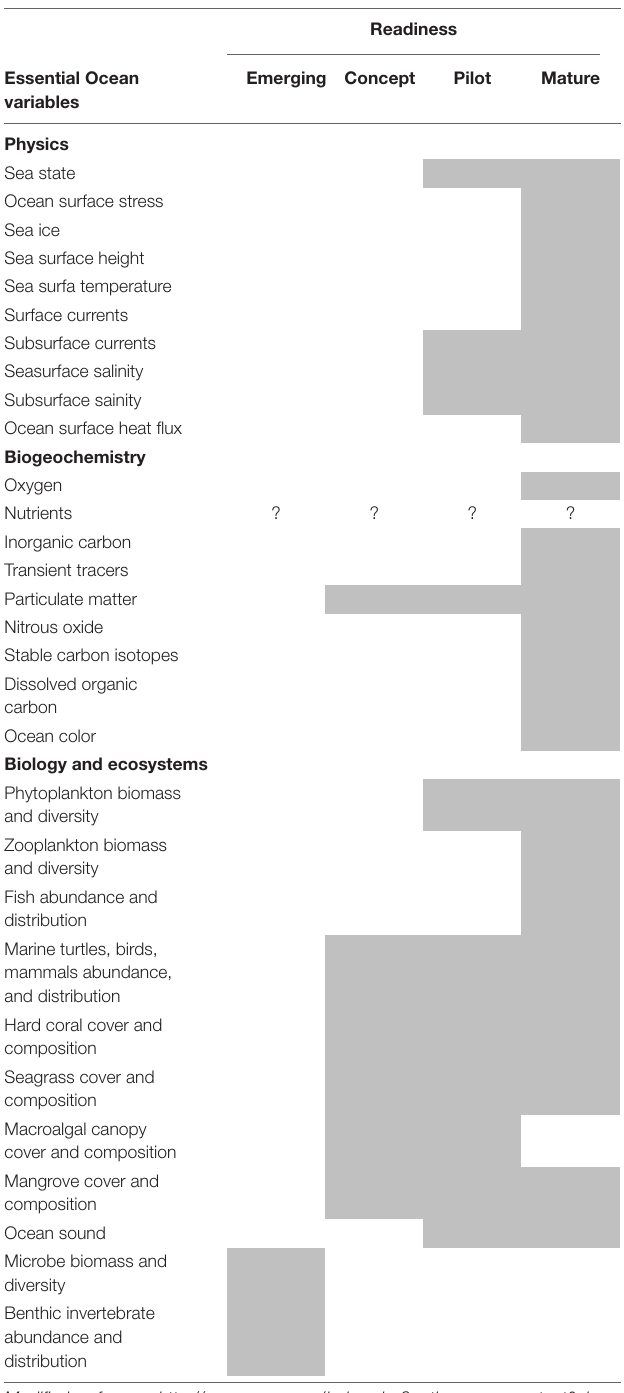
TABLE 3 | List of the 11 MSFD qualitative